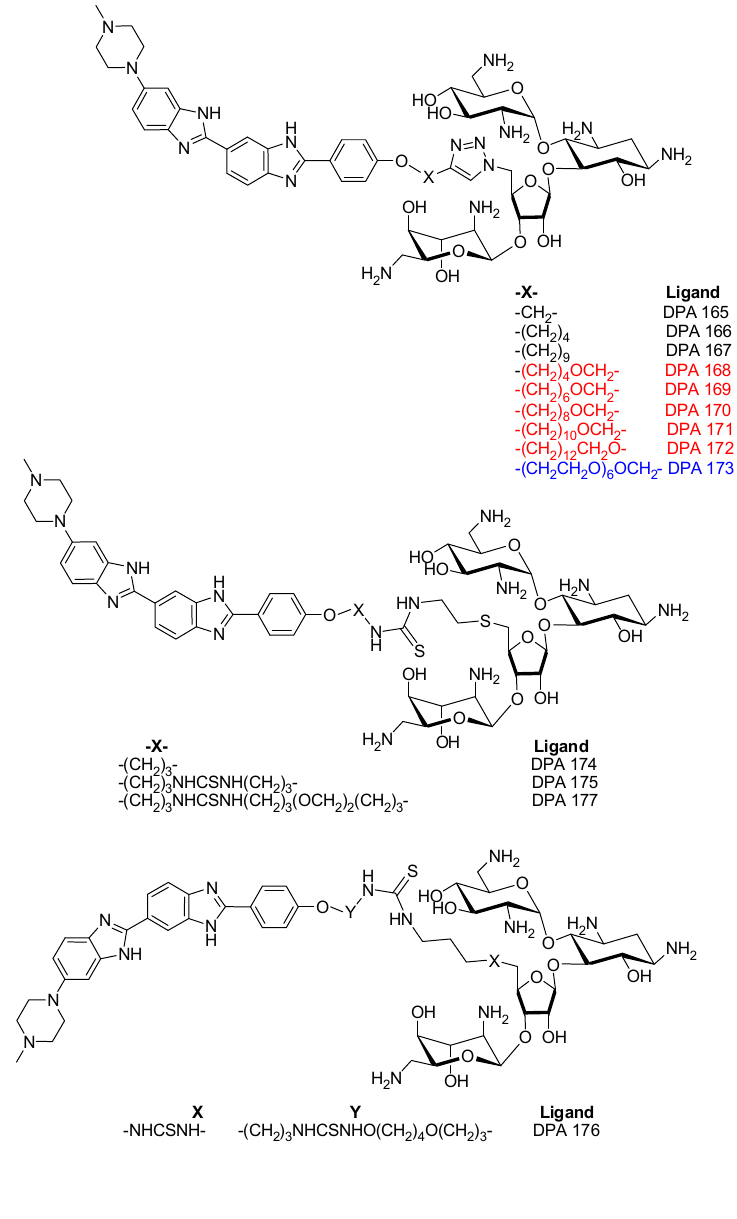
Figure 2. Structures of neomycin-Hoechst 33258 conjugates used in the